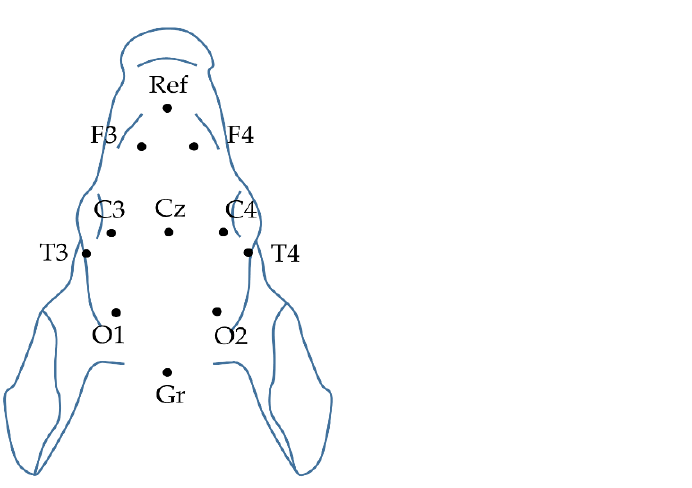
Figure 9. Plan view of the piglet scalp with the modified neonatal EEG montage according to the international 10–20 system.